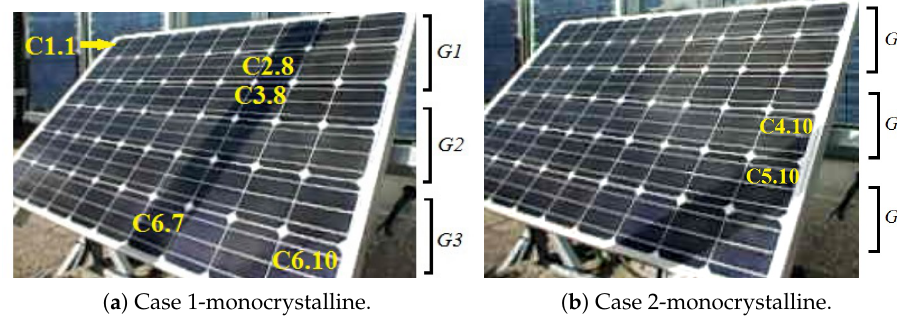
Figure 14. Experimental tests for monocrystalline PV